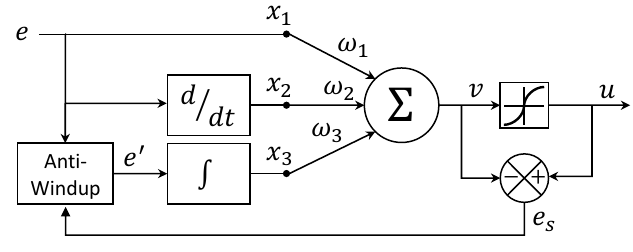
Figure 4. Adaptive single neuron PID